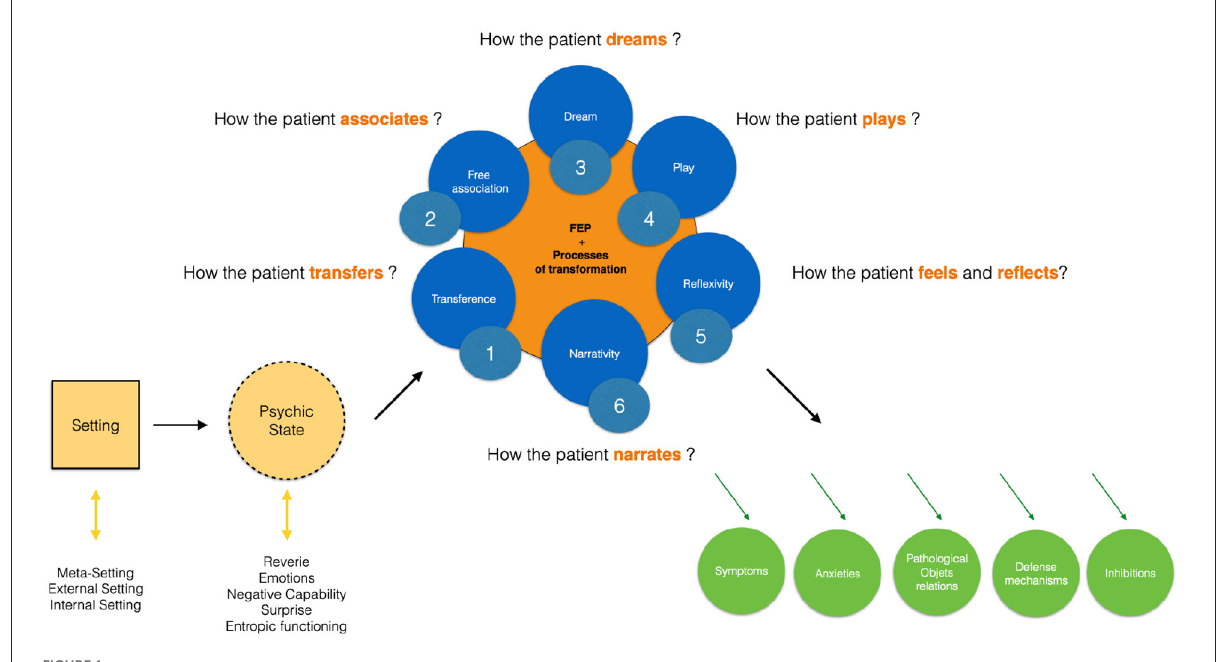
FIGURE1 Main components of psychoanalytical